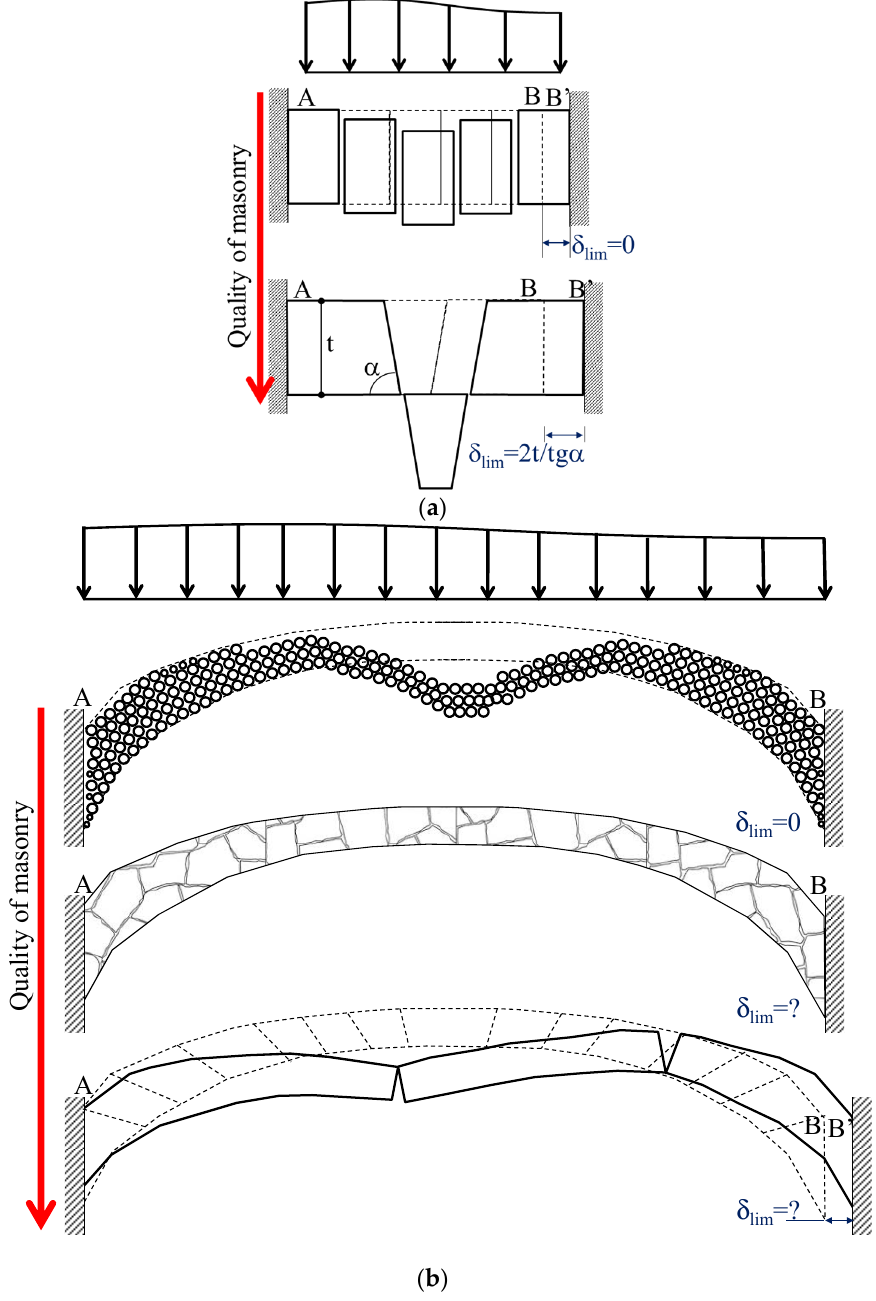
Figure 1. Maximum horizontal displacement δ lim of ( a ) flat and ( b ) curved arches with different qualities of masonry.